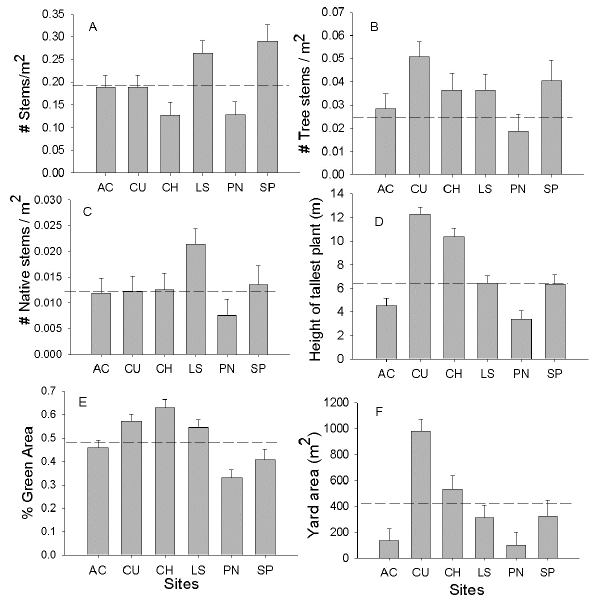
Fig. 3 . One way-ANOVA results for yard characteristics across six watershed sites (AC = Avenida Central, CU = Cupey, CH = Chiclana, LS = La Sierra, PN = Puerto Nuevo, SP = San Patricio). A) Stem density B) Tree stem density, C) Native stems density, D) Height of tallest plant, E) Percentage of yard green area, F) Yard Area. Dashed lines represent the grand mean of all values for the watershed and bars represent standard errors around the site